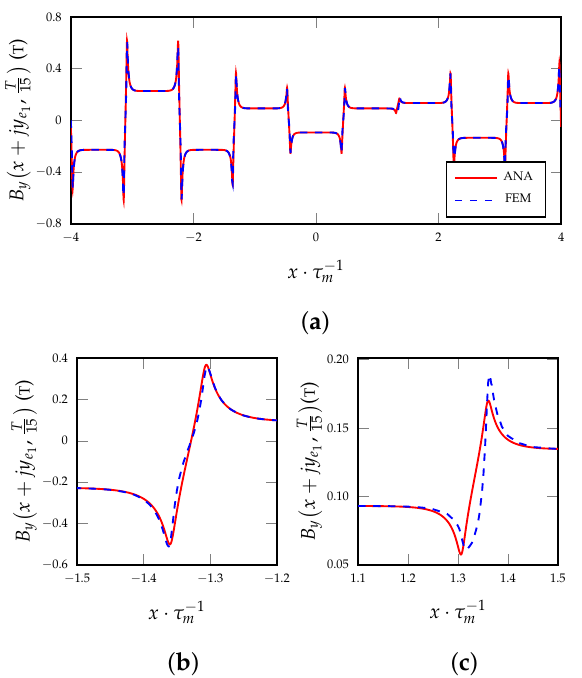
Figure 6. Analytical (6) and FEM (slotted machine of Figure 4a) armature reaction flux density normal component on the exploration line at y e N x = 10,000). ( c , b ) are two different selective zoom of ( a ).